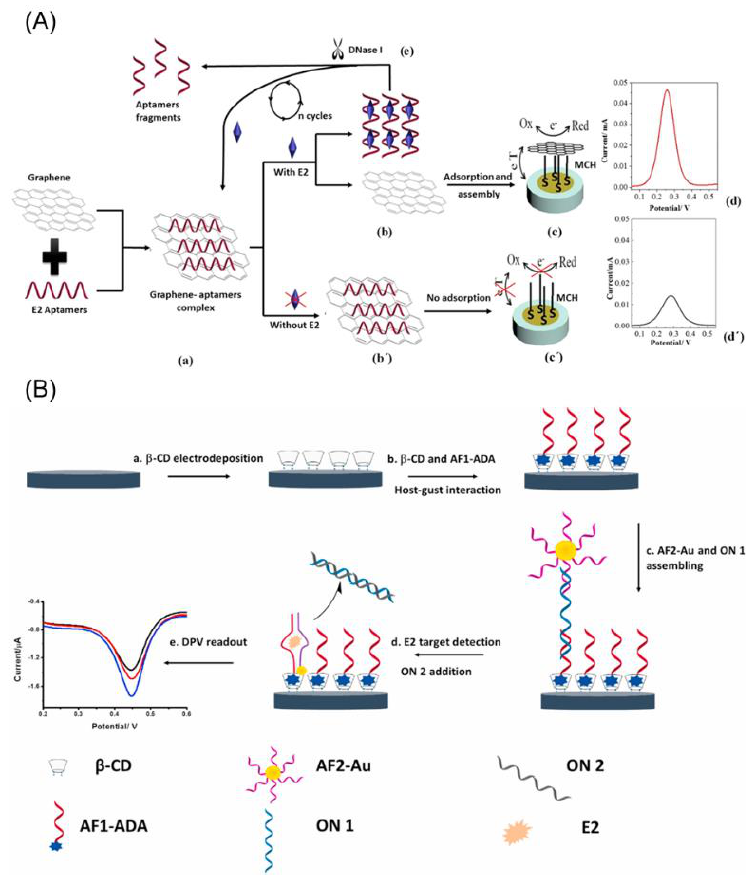
Figure 6. ( A ) Design and mechanism of E2 aptasensing technique based on graphene – aptamer complex and DNase 1 enzyme. Reprinted with permission from Ref. [44]. copyright © 2022, Elsevier, ( B ) Fabrication and mechanism of E2 aptasensor composed of aptamer fragments (AF1, AF2) and oligonucleotides (ON1, ON2). Reprinted with permission from Ref. [43]. copyright © 2022, Elsevier.